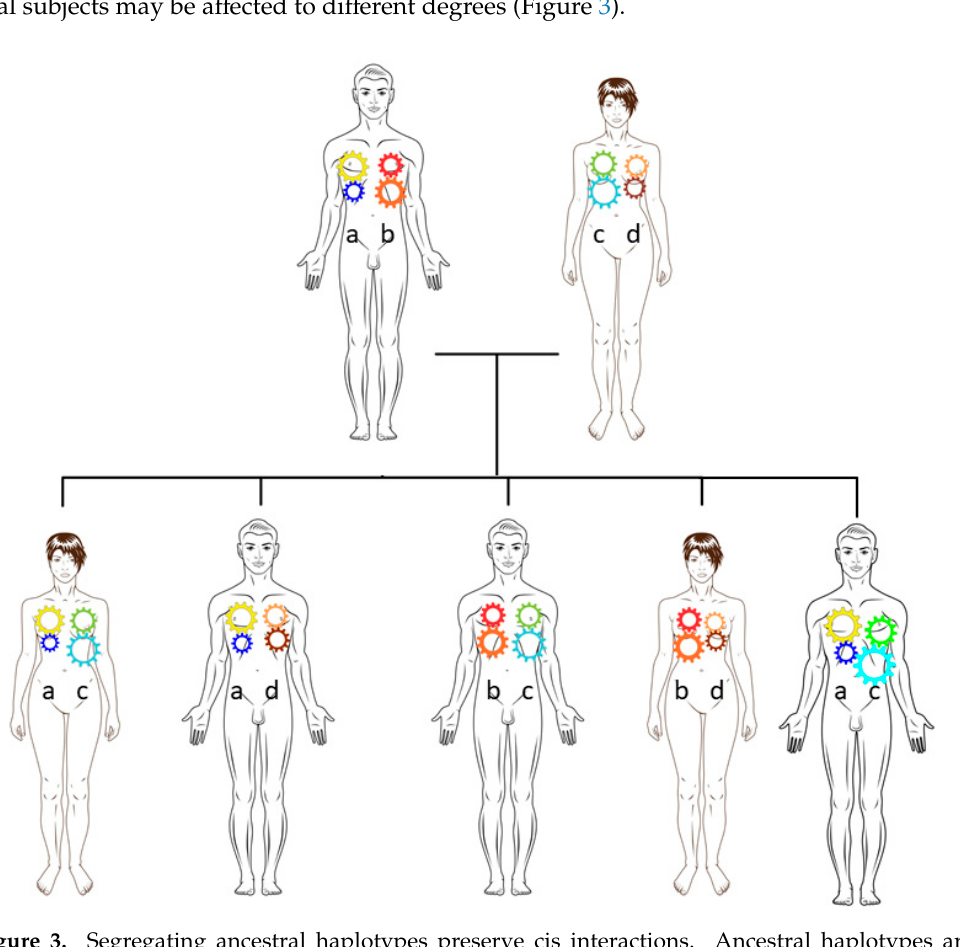
Figure 3. Segregating ancestral haplotypes preserve cis interactions. Ancestral haplotypes are represented by two cogs meshing vertically (in cis ). The size and shape of cogs represent polymorphism or variant forms of the blocks. For example, the father has yellow–blue (a) and red– orange (b) haplotypes while the mother has green-cyan (c) and orange-brown (d) haplotypes. Haplotype (a) has been transmitted to the eldest daughter, eldest son, and youngest son. The middle two children have inherited haplotype (b). Reactive meshing is dependent on hormonal and other environmental influences. The oldest and youngest offspring are genotypically identical, but the interactions are different as a consequence of the sexual environment. Adapted with permission from [5].